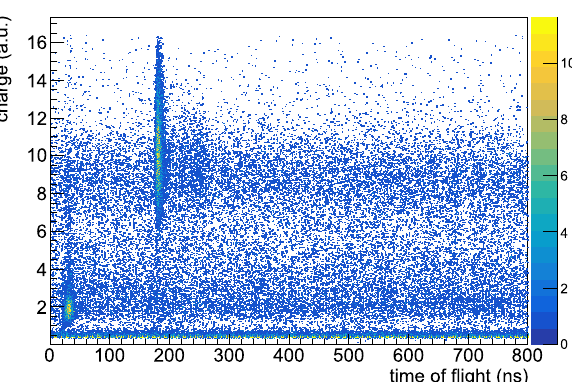
Fig. 2 Pulse charge versus time-of-flight for the 6 LiGl detector placed in the beam line for monitoring of the beam energy. Neutron signals can bedistinguishedbytheirhighcharge.Inthisway,theyarediscriminated from the ambient γ -ray background associated to a low charge